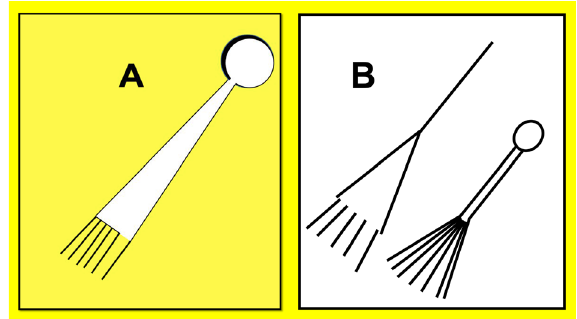
Figure 1. Comparison of a Hopewell earthwork located in near the Hopewell airburst epicenter in Clermont County, Ohio, USA and eyewitness hand drawings of the ~ 12 megaton Tunguska airburst, which occurred on June 30, 1908, in Yeniseysk Governorate, Russia. ( A ) the Milford earthwork; ( B ) assemblage of hand sketches of the Tunguska airburst event 11 . Kenneth Barnett Tankersley created the images using Microsoft PowerPoint for Mac Version 16.41 (www. micro soft. com).